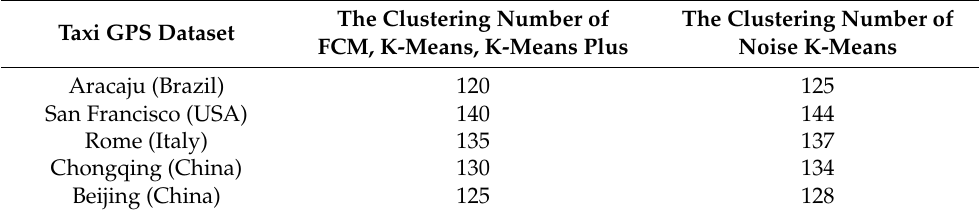
Table 2. The clustering numbers of the taxi GPS data.